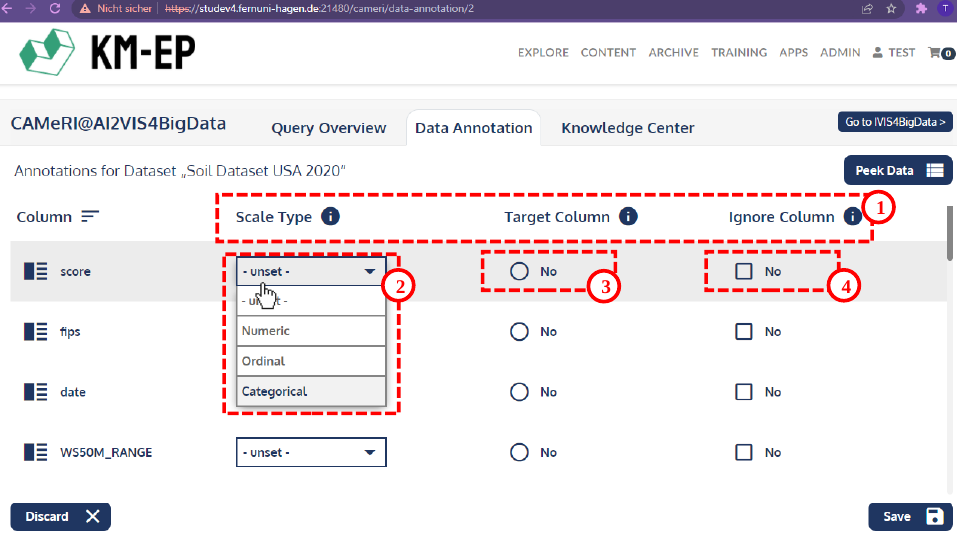
Figure 17. Data annotation as example for an action during the cognitive walkthrough.